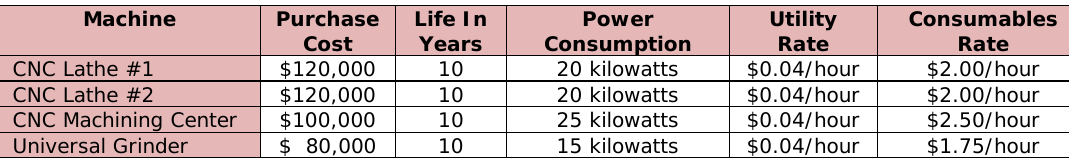
Table 1. “Machine cost and usage information”.